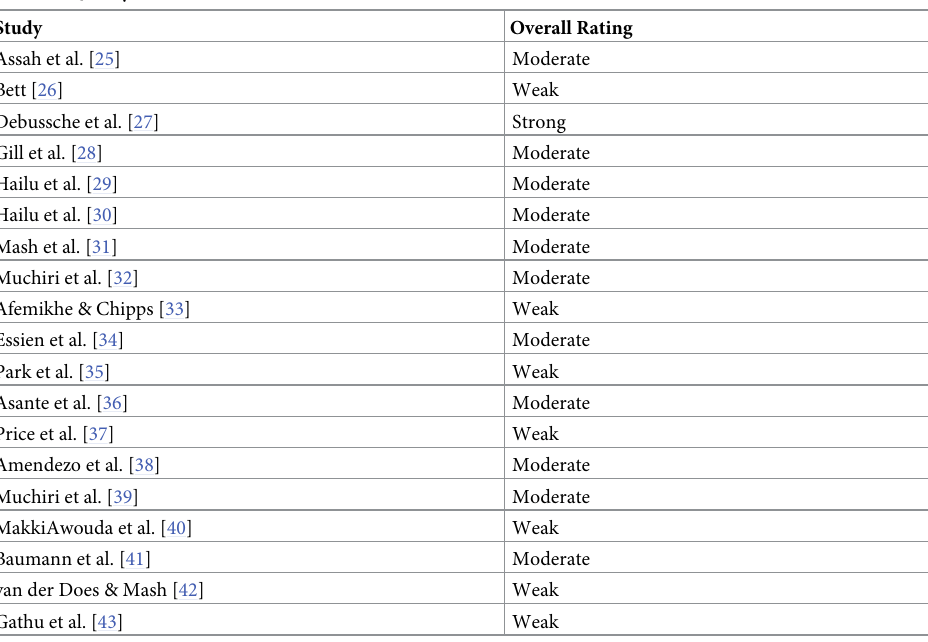
Table 1. Quality assessment of the included